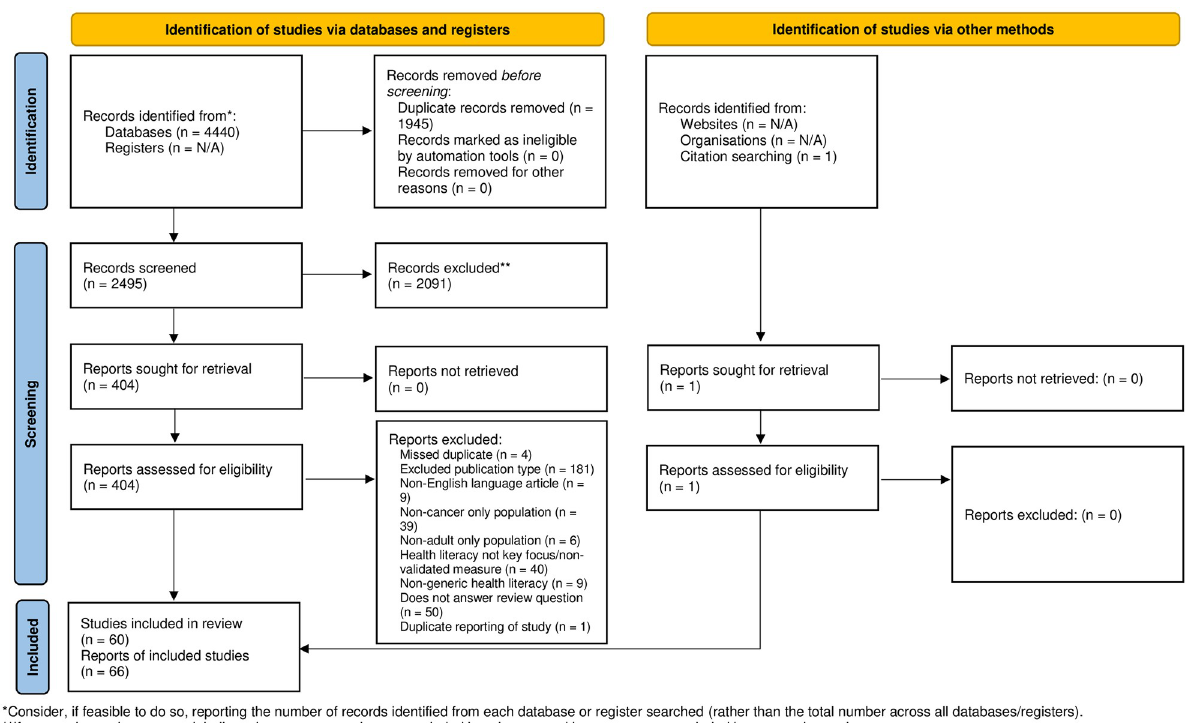
Fig 1. PRISMA diagram showing number of records reviewed at each step of the process. From: Page MJ, McKenzie JE, Bossuyt PM, Boutron I, Hoffmann TC, Mulrow CD, et al. The PRISMA 2020 statement: an updated guideline for reporting systematic reviews. BMJ 2021;372:n71. doi: 10. 1136/bmj.n71. For more information, visit: http://www.prisma-statement.org/.